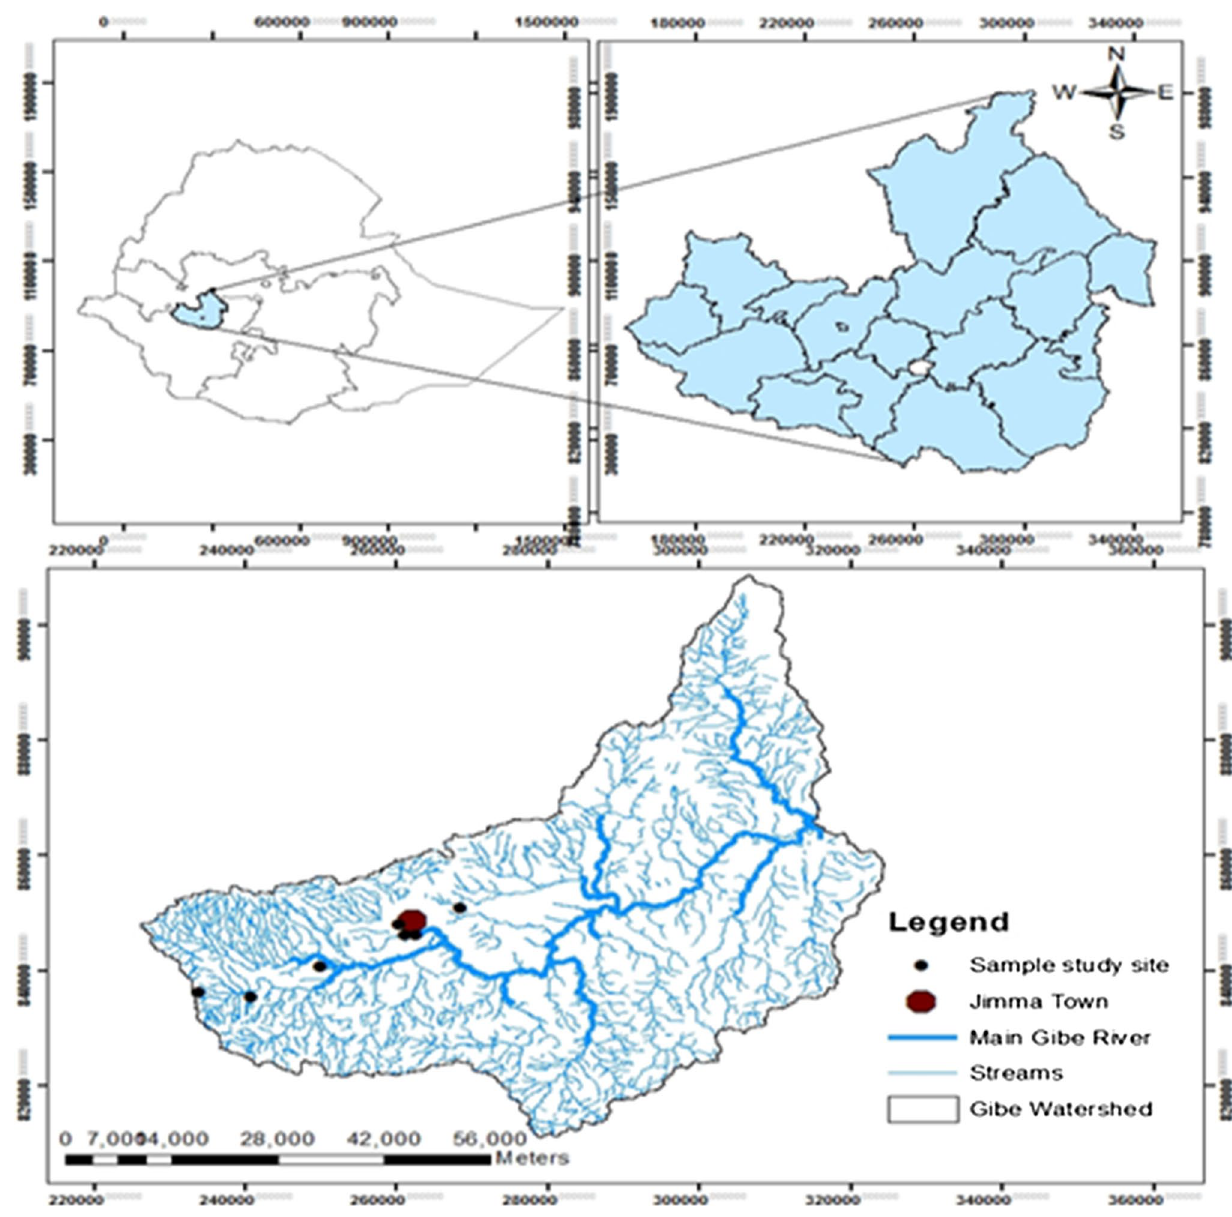
Fig. 1 Map of the study database, altitude, longitude and latitude sampling sites were recorded using GPS (global positioning system) reading.